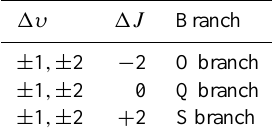
Table 2. The shift of wave number of nitrogen and water vapor. Molecule Excitation (cid:49)k The center of wavelength (cid:49)υ = 1, the Q branch (cid:49)J = 0 Nitrogen 354.7nm 2330.7cm − 1 386.7nm Water vapor 354.7nm